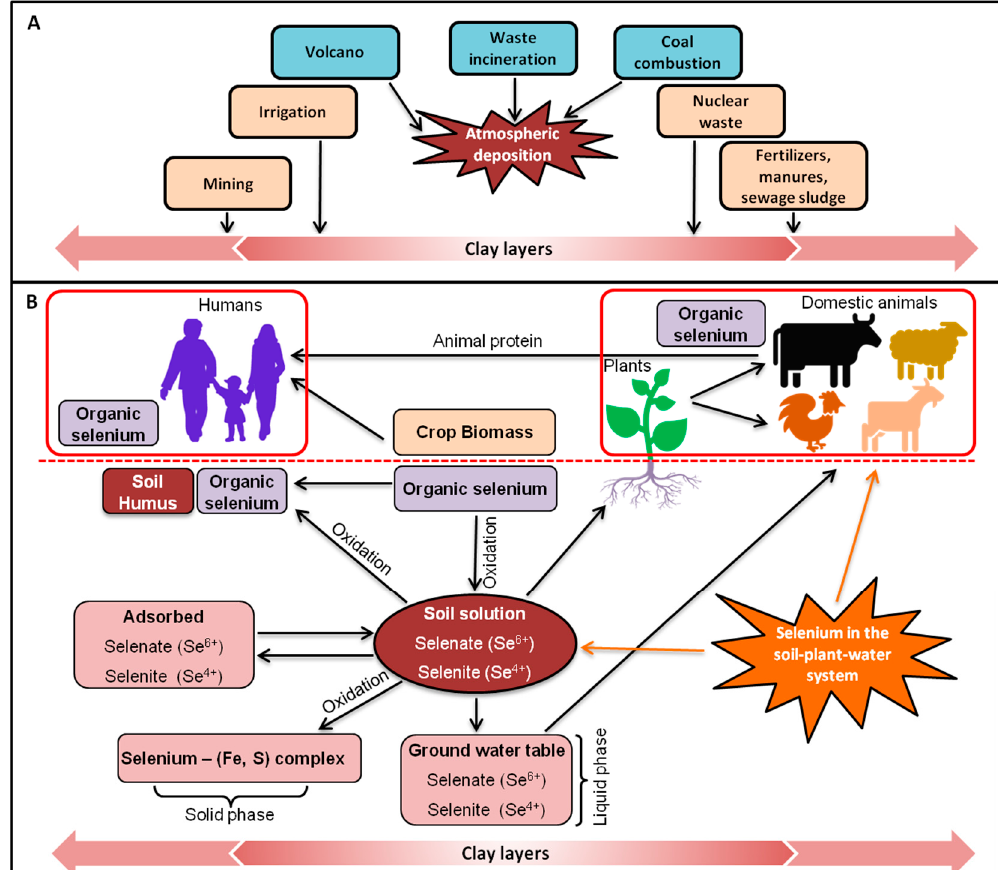
Figure 2. An overview of Se in the environment. ( A ) Sources of Se in the environment; ( B ) Selenium in the soil-plant-water consumer system. Plant roots take up Se (selenate or selenite) from the soil solution. The Se concentration in the soil solution depends on the solubility of the Se forms occurring and the biological transformations of organic forms. Modified from Hasanuzzaman et al. [59].